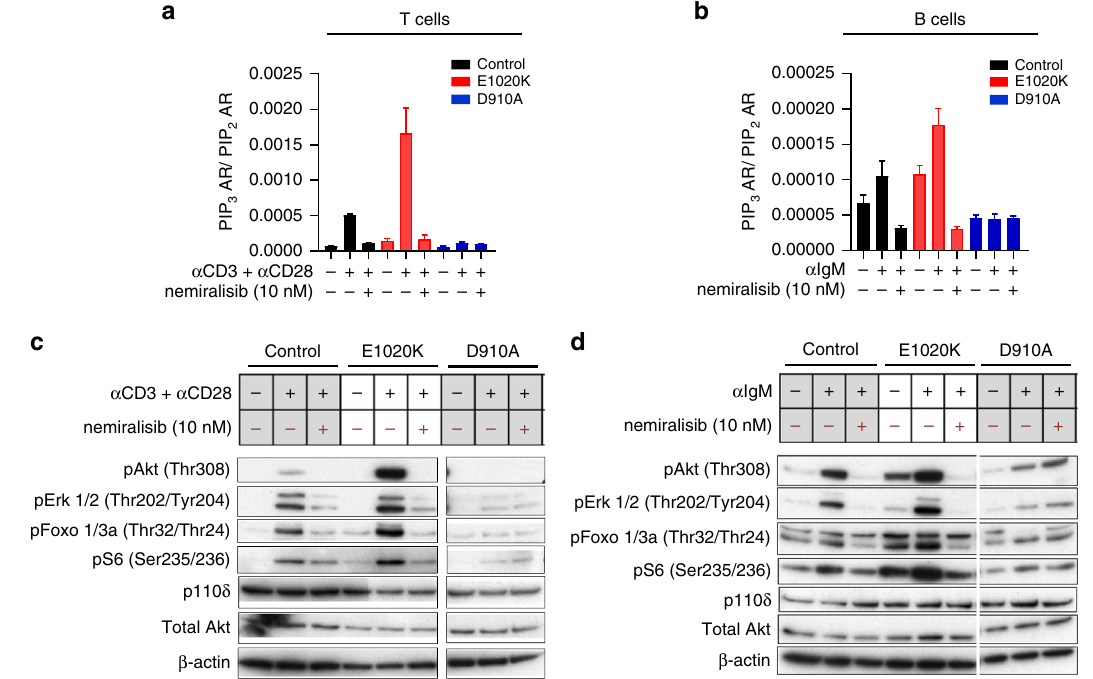
Fig. 2 PI3K δ hyper-activation leads to increased PIP 3 and pAKT levels that can be reduced using a selective PI3K δ inhibitor. a PIP 3 levels in puri fi ed T cells from wild-type, p110 δ E1020K and p110 δ D910A mice, unstimulated or stimulated with anti-CD3 and anti-CD28 in the presence or absence of the selective PI3K δ inhibitor, nemiralisib (mean ± SD; n = 2 – 3). b PIP 3 levels in puri fi ed B cells from wild-type, p110 δ E1020K and p110 δ D910A mice unstimulated, or stimulated with anti-IgM in the presence or absence of nemiralisib (mean ± SD n = 2 – 6). c Western blots of puri fi ed T cells from wild-type, p110 δ E1020K and p110 δ D910A mice, unstimulated or stimulated with anti-CD3 and anti-CD28 in the presence or absence of nemiralisib. d Western blots of puri fi ed B cells from wild-type, p110 δ E1020K and p110 δ D910A mice, unstimulated or stimulated with anti-IgM in the presence or absence of nemiralisib. (Representative